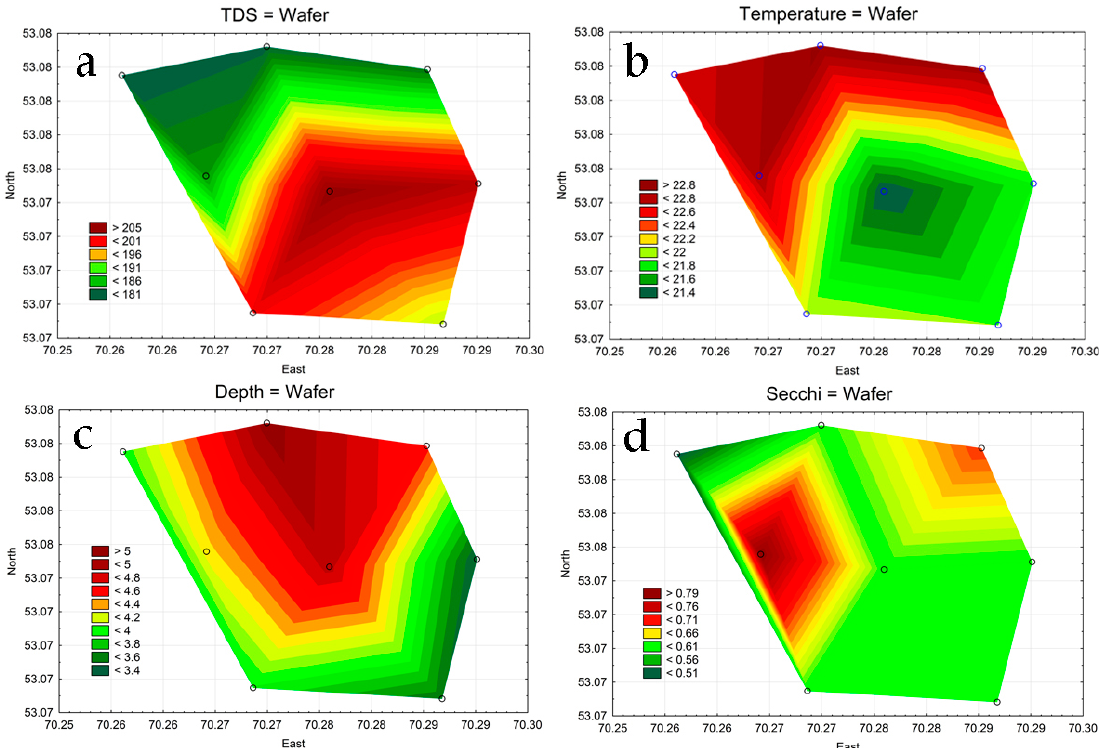
Figure 2. Distribution of major environmental variables in the sampling stations of Lake Borovoe’s surface, 2019. TDS ( a ), water temperature ( b ), lake depth ( c ), and transparency by Secchi disk ( d ).